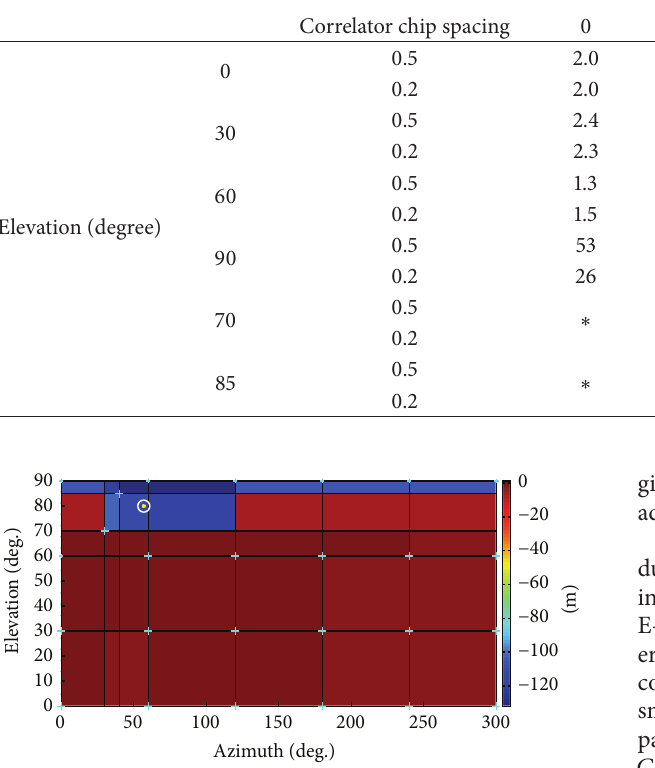
Figure 4: Changing interference incident angle—variation of Δ𝜌 𝑝 𝑉 .